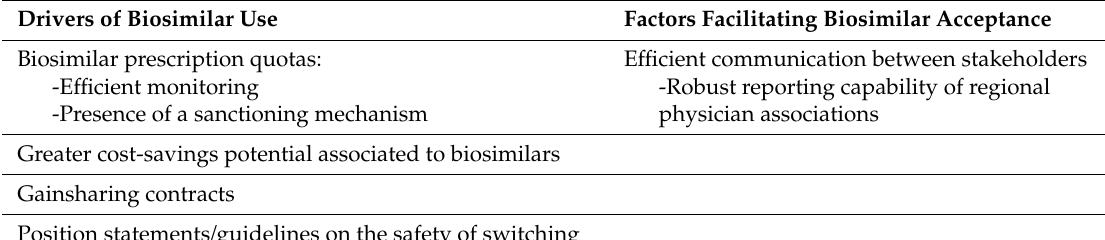
Table 2. Summary of factors identified to drive biosimilar use and facilitate biosimilar acceptance in Germany. These factors have been identified through the qualitative analysis of interview